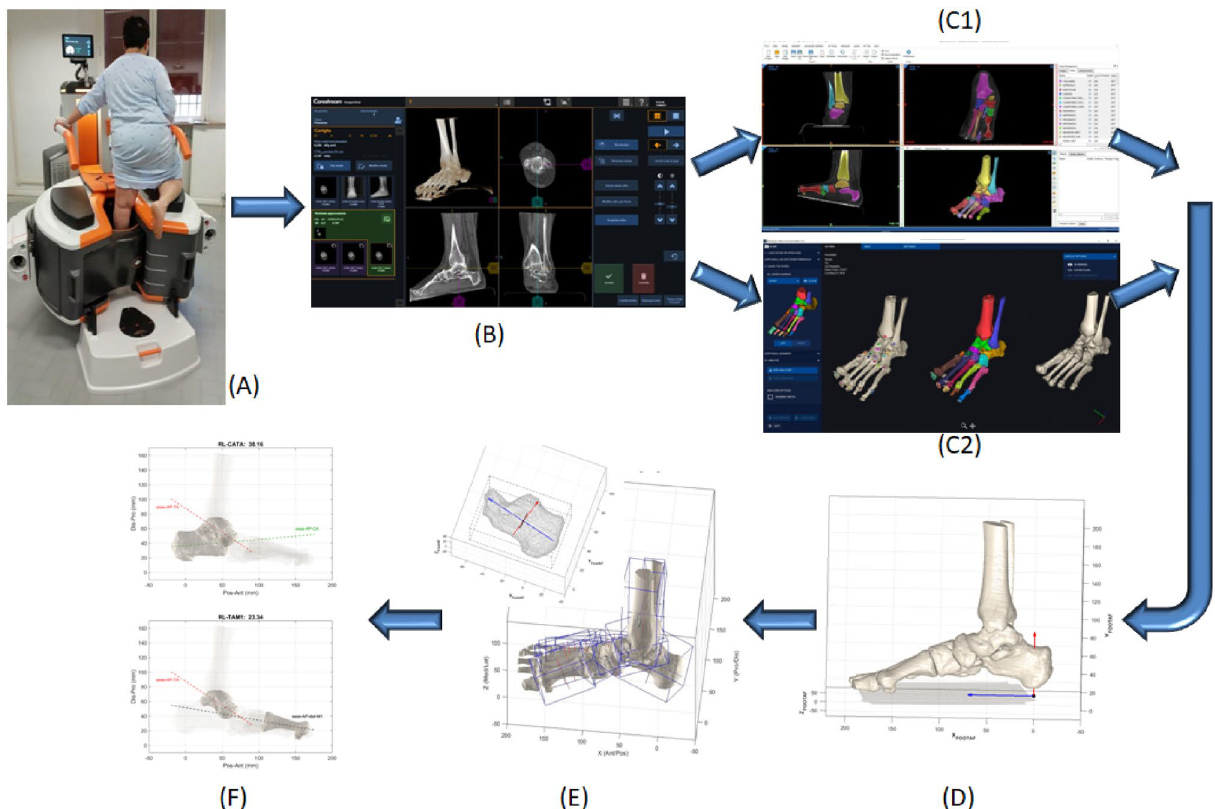
Figure 1. Diagram representing the full process from CBCT scans to bone angular measurements. A typical patient in single-leg weight-bearing during the CBCT scan ( A ). The 3D data-set including volume rendering of the foot is available at the interactive screen ( B ). This Dicom file is used both with the MIS ( C1 ) and DIS ( C2 ) software, respectively for the semi-automatic and automatic bone segmentation process: all foot and ankle bone segments eventually were modelled separately, and the ground segment is also identified. The same bone models, but in the foot anatomical reference frame (FootAF), here in a lateral view ( D ). Construction of the three anatomical axes by means of the PCA technique ( E ): an exemplary application to the calcaneus model with the three axes depicted (above), and the same for all foot bone models (below). Exemplary diagrams for the calculated angular measurements ( F ): in the lateral projection, the angle between the talus and calcaneus (RL_TACA, above) and between the talus and the 1st metatarsus (RL_TAM1, below), i.e. the Meary’s